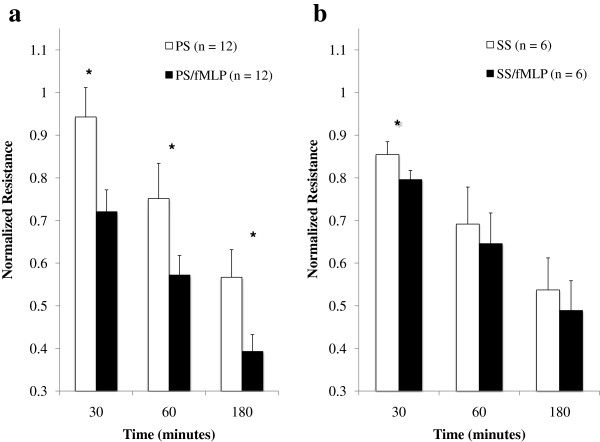
N-formyl-l-methionyl-l-leucyl-l-phenylalanine treatment of primary sepsis leads to more profound loss of barrier function. Change in monolayer resistance at 30 minutes, 60 minutes, and 180 minutes. Groups were analyzed using two-way repeated-measures analysis of variance with Holm–Sidak post-hoc analysis. Values presented as mean ± standard error of the mean. Whereas primary sepsis (PS) neutrophils could be further stimulated at every time point (a), this effect was only present at 30 minutes for secondary sepsis (SS) neutrophils; no difference was noted thereafter (b). *P <0.05. fMLP, N-formyl-l-methionyl-l-leucyl-l-phenylalanine.